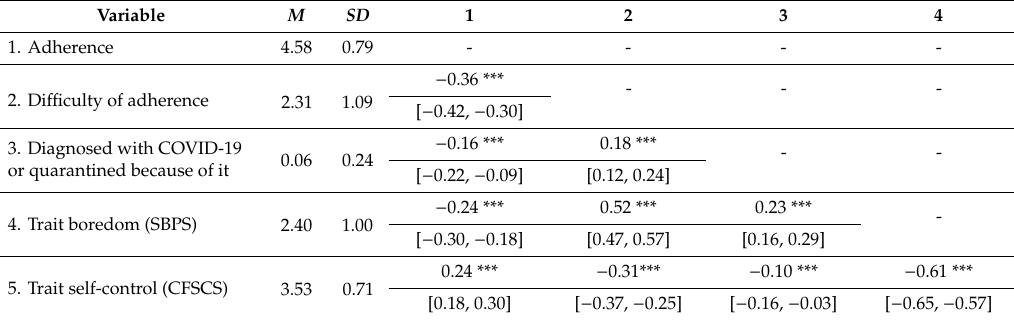
Table 1. Means, standard deviations, and correlations between key